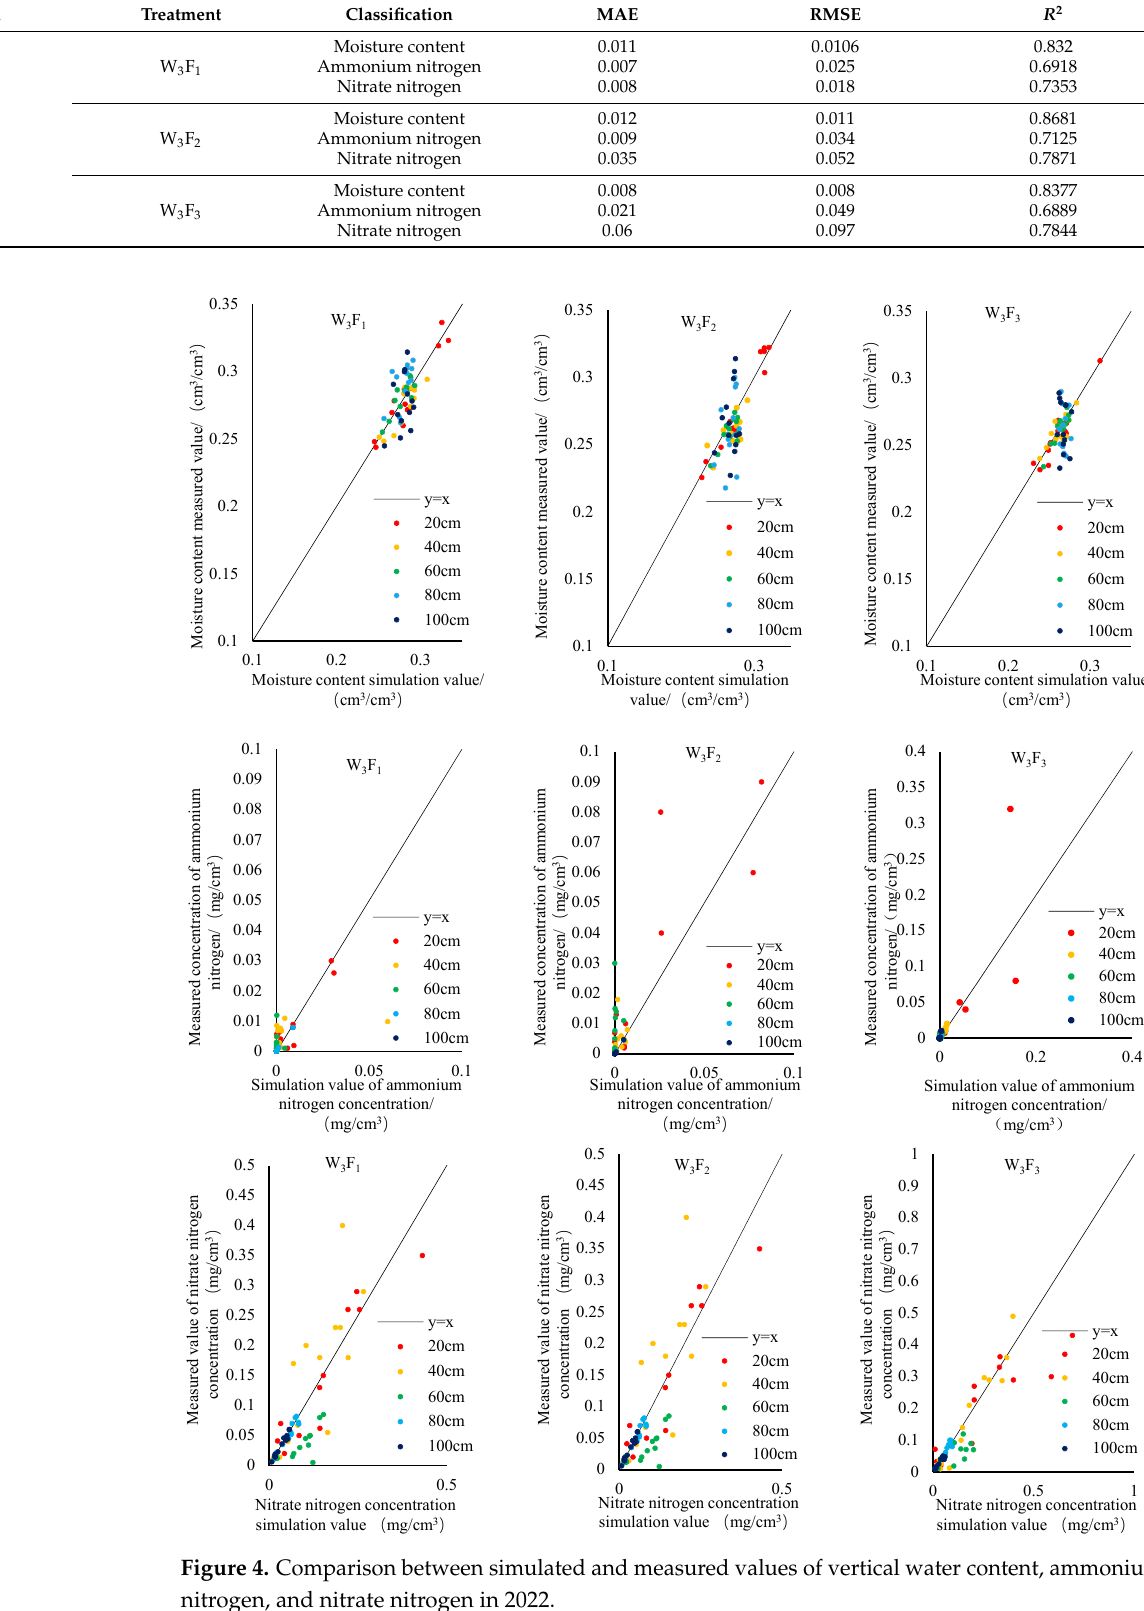
Figure 4. Comparison between simulated and measured values of vertical water content, ammonium nitrogen, and nitrate nitrogen in 2022.